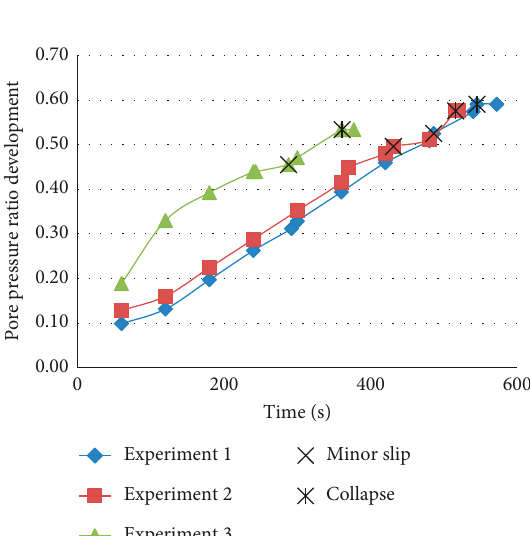
Figure 9: Safety factor against time.